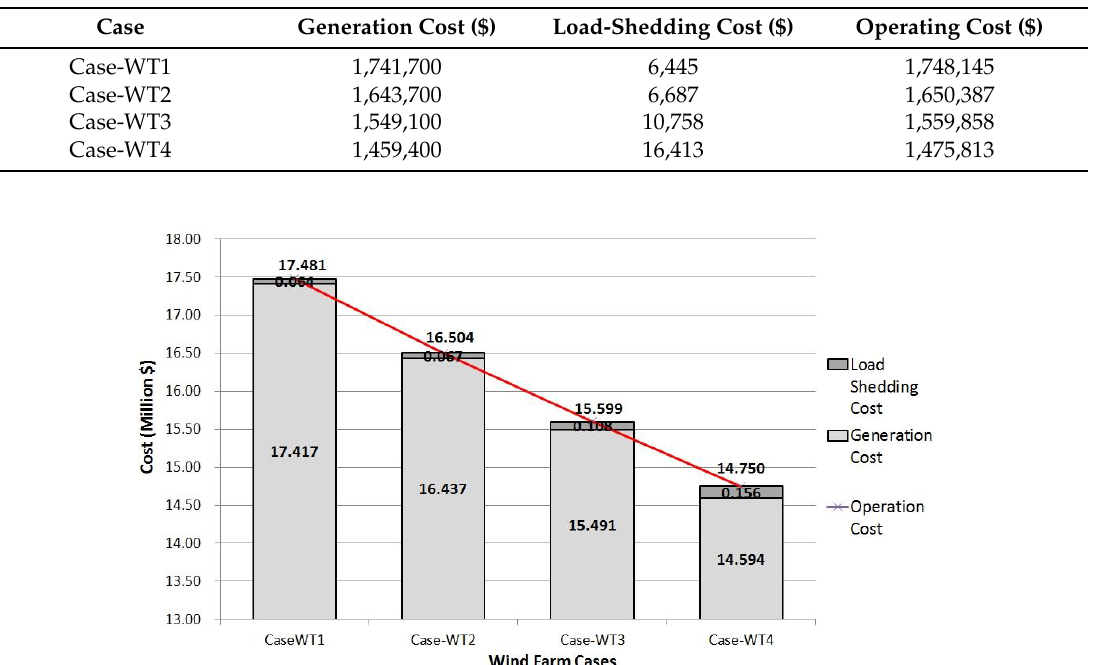
Table 6. Simulated costs for scenarios Case-WT1, Case-WT2, Case-WT3, and Case-WT4.